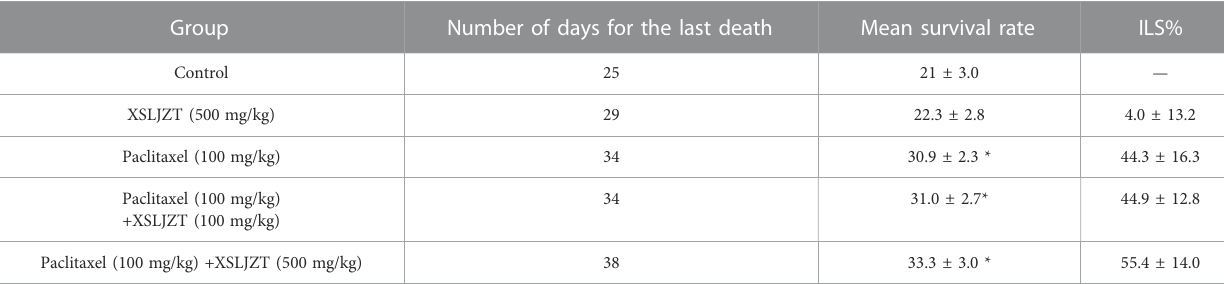
TABLE 2 Survival rate of P388-CD2F1 tumor-bearing mice with different treatments. Group Number of days for the last death Mean survival rate ILS%